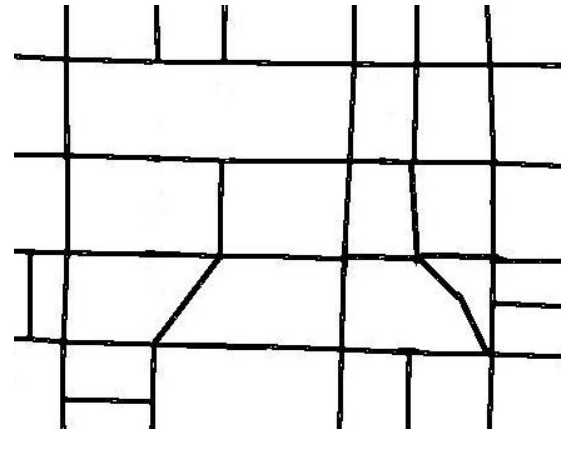
Figure 6. Road map of simulations.